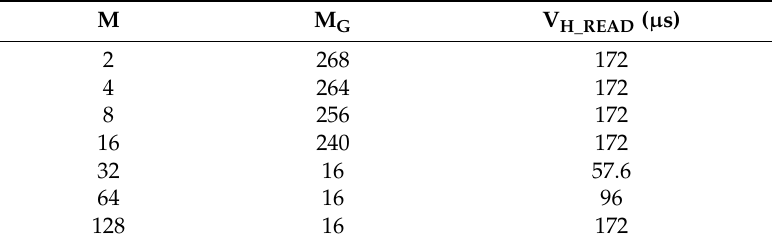
Figure 15. Timing diagram of signal readouts and A/D conversion.